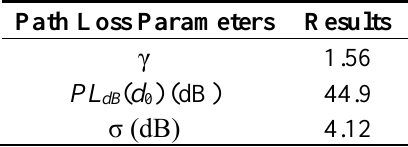
Figure 14. Measured and modeled path loss for off-body channel vs. logarithmic transmitter (Tx) and receiver (Rx) separation distance 1.9 GHz for the dual band PIFA. Table 4. Off-body path loss parameters at 1.9 GHz.